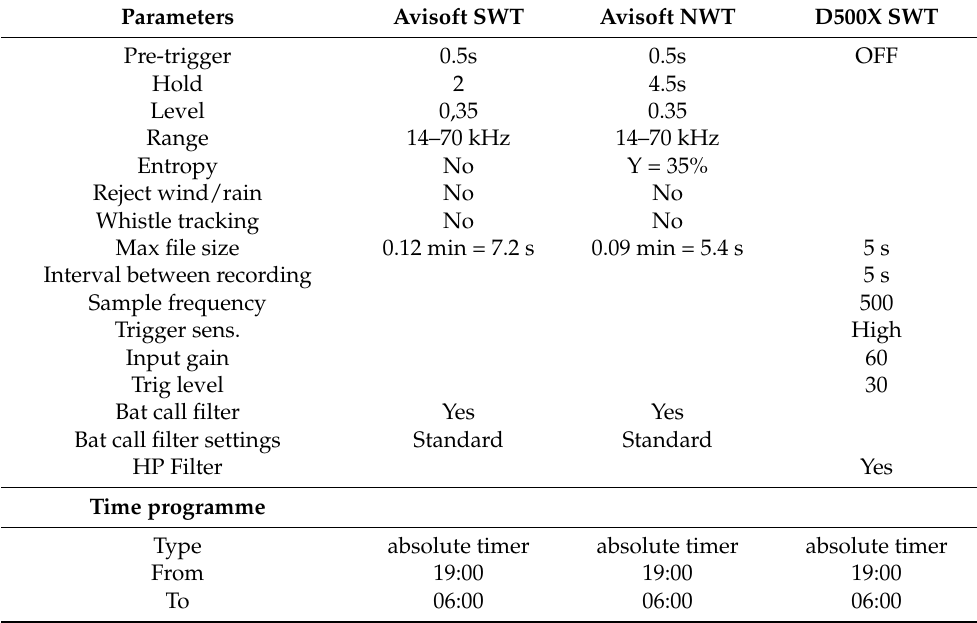
Table A1. Settings of Avisoft and the